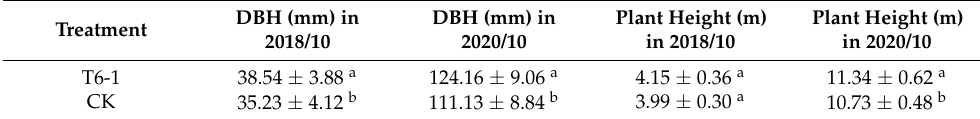
Table 1. Changes in DBH and plant height of poplar trees.